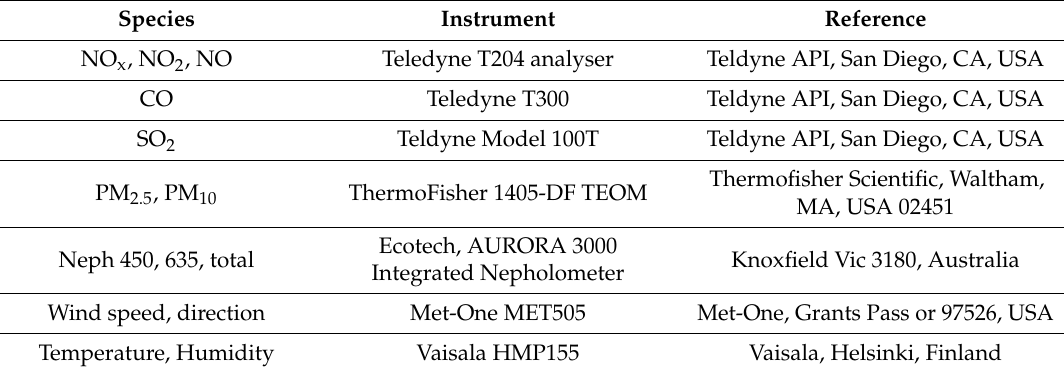
Table 3. Instruments included in the Mobile air quality station and the gas species analysed.